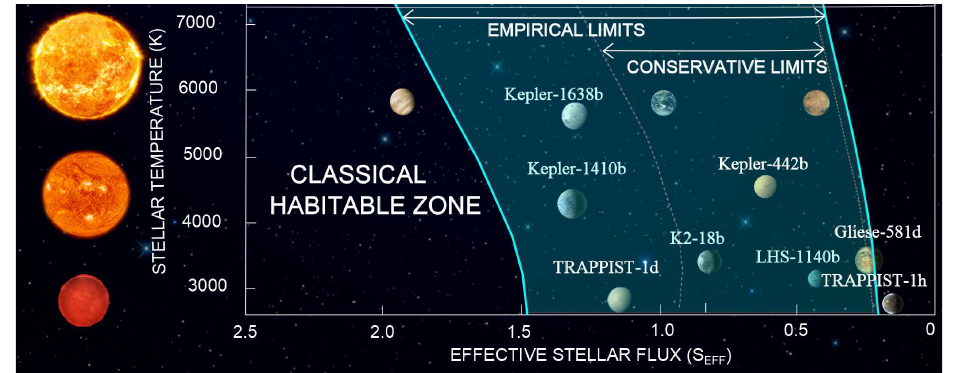
Figure 3. The classic CO 2 –H 2 O habitable zone with stellar effective temperature ( T EFF = 2600–7200 K) as a function of the effective stellar flux ( S EFF ). From left to right, the “recent Venus” and “early Mars” limits (solid blue curves) are the empirical (optimistic) classical HZ limits, whereas the “Leconte et al.” and “Maximum Greenhouse” limits compose the conservative (pessimistic) classical HZ limits. Some solar system planets and confirmed exoplanets are shown. Based on work from Kopparapu et al. [26,49].